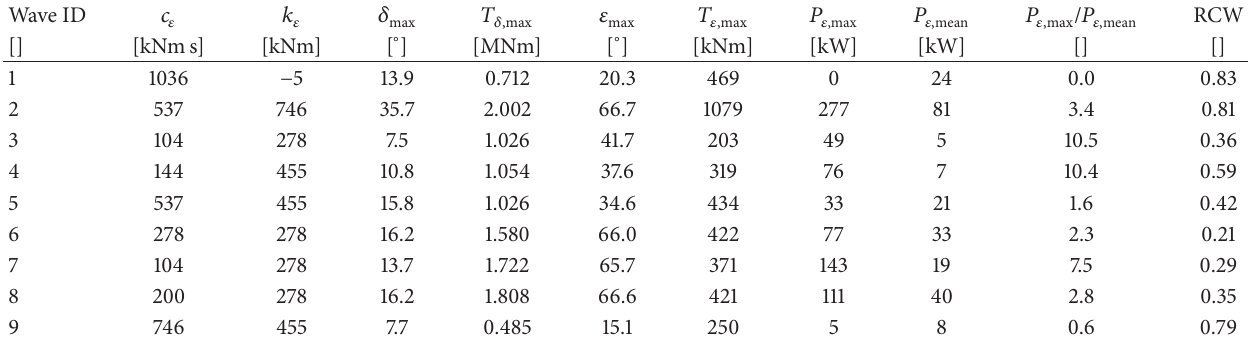
Figure 8: (a) Wave force versus pitching velocity and (b) wave elevation versus pitch angle. Table 3: Results obtained for the linear reactive controller: main physical variables that characterize the system response to the considered waves.